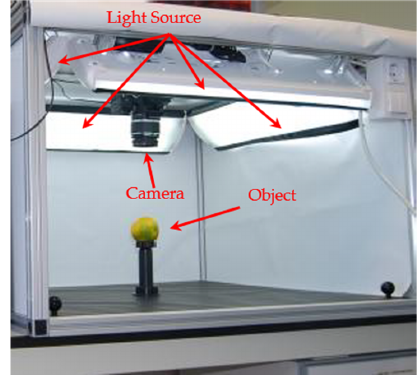
Figure 8. Schematic of the chamber experiment set-up.